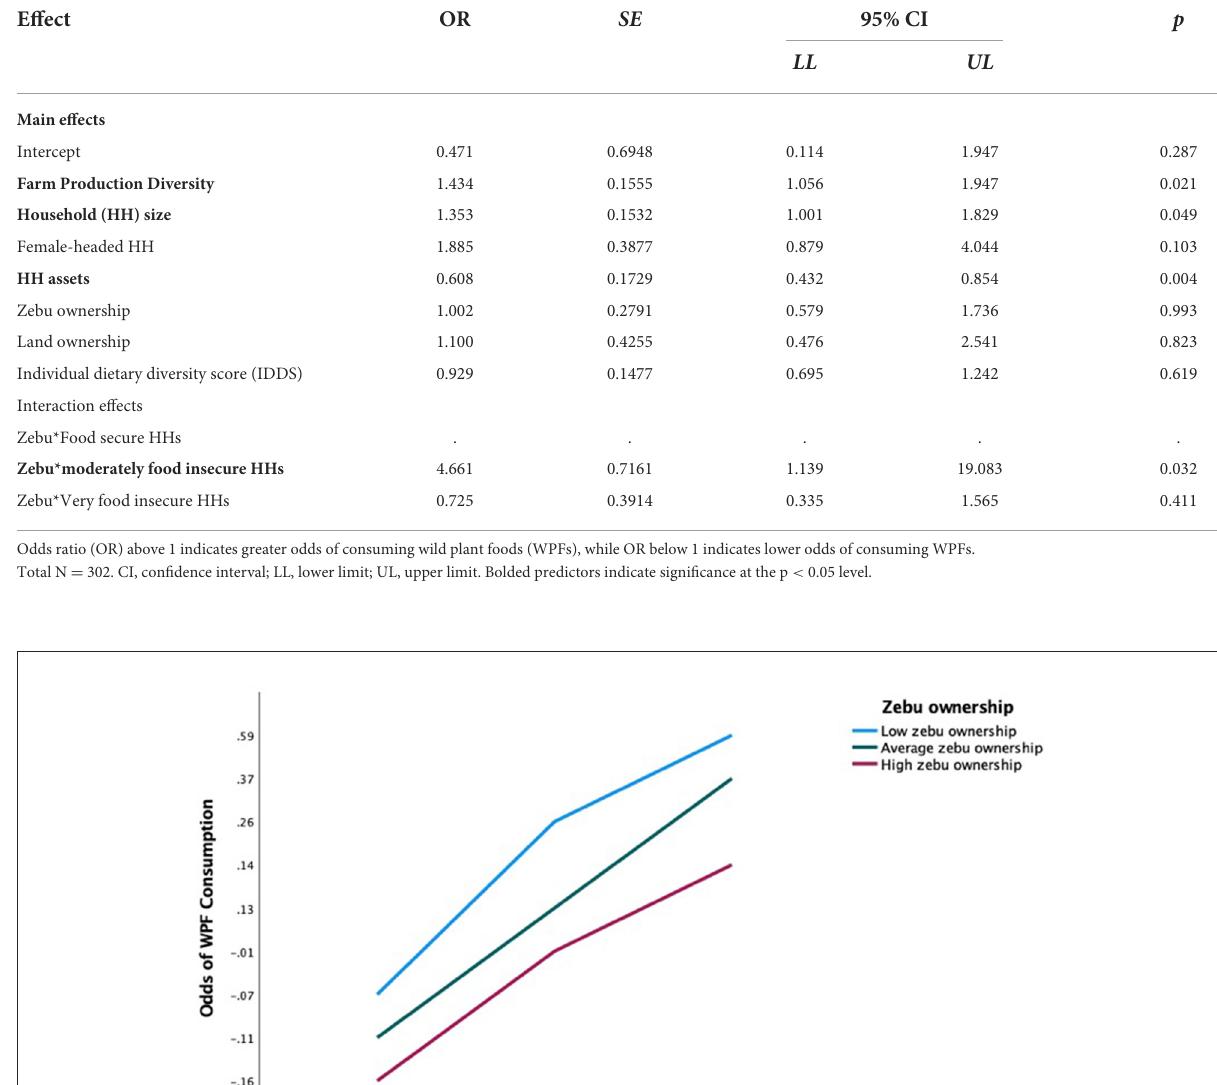
TABLE 6 Main effects and interaction effect from random effects Model 2.